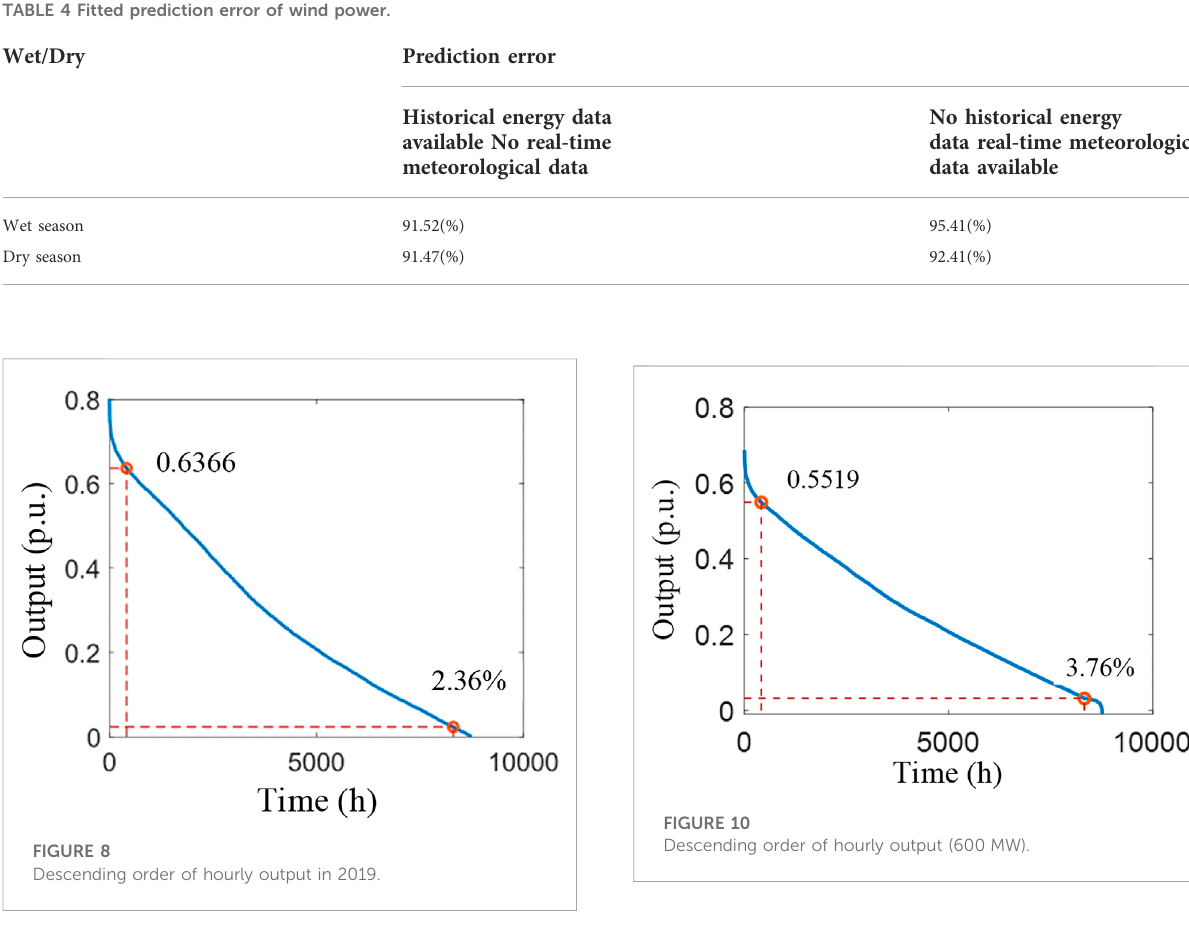
TABLE 4 Fitted prediction error of wind power.